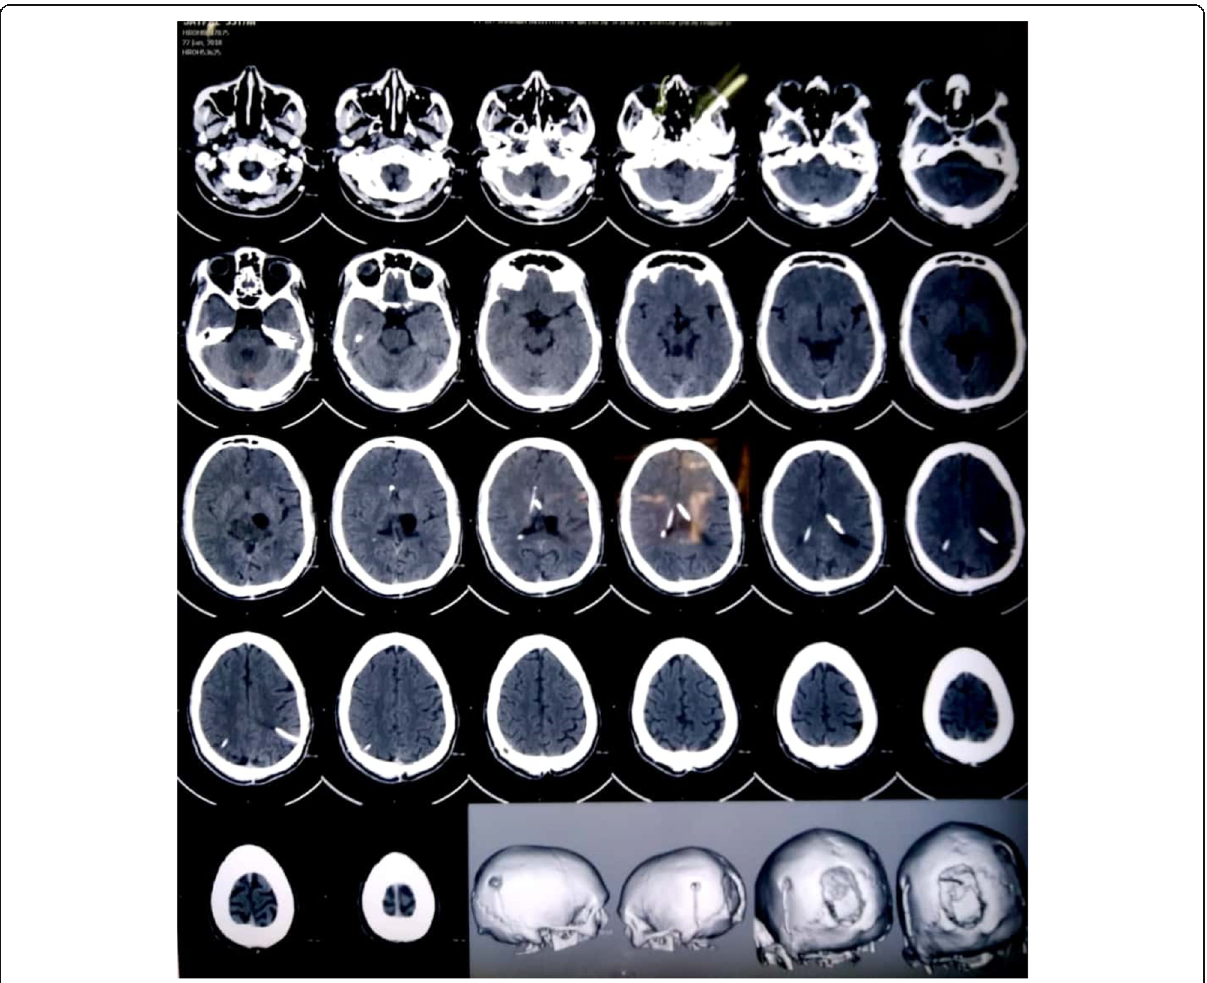
Fig. 1 MRI brain showing presence of ventricular ends of right VP shunt indicated by the arrow (only left shunt is